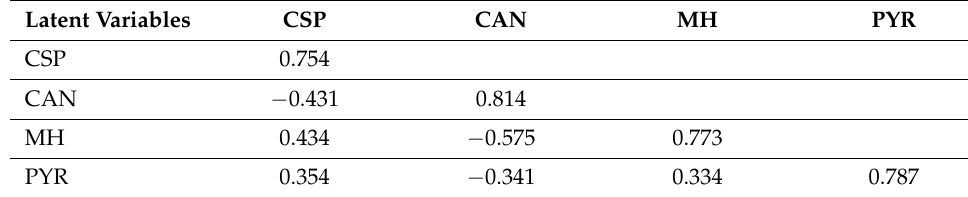
Table 4. Discriminant validity.